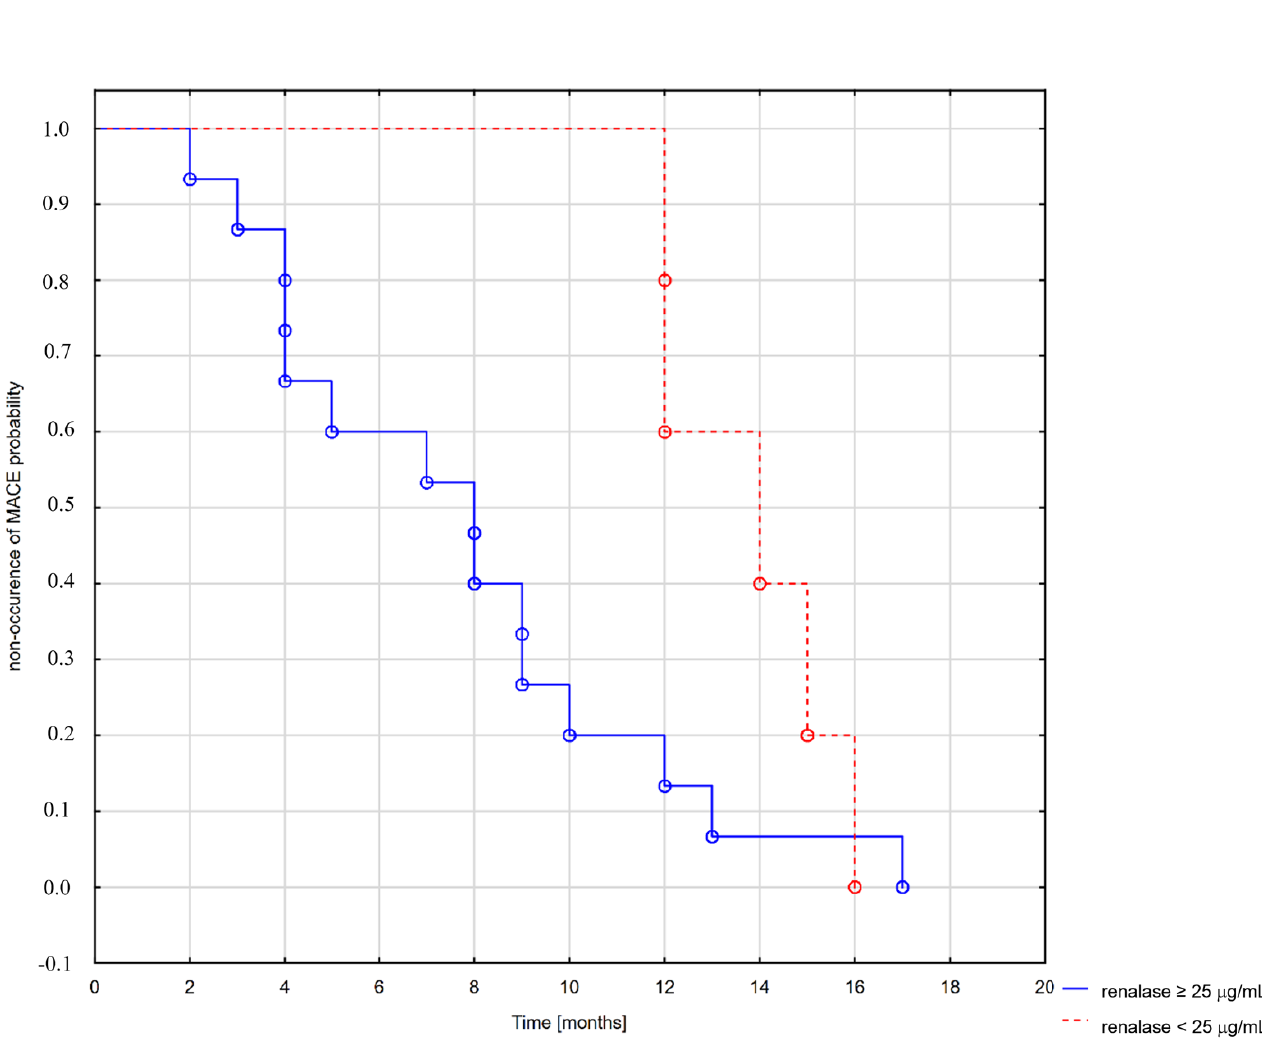
Figure 3. Kaplan Meier curve for MACE in groups with low and elevated renalase levels.